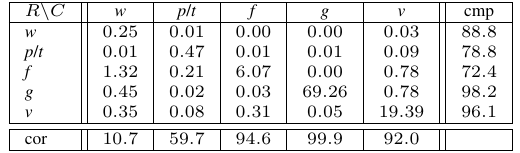
Table 7. Confusion matrix, completeness (cmp) and correctness (cor) for the variant CRF 5 200 using neighborhood N opt ,λ . The numbers in the confusion matrix are the respective percentage of the whole test set. R \ C : Reference (rows) vs. classification results (columns). neighborhood than for N 50 , in the order of 2 % for the first and of 1 % for the latter if 200 trees are used for the association potential. Consequently, the variant N opt ,λ performs better than N 50 in all cases, the margin being in the order of 1 %. If RF 100 is used for the association potential, this also holds for N opt,dim , whereas in case 200 trees are used N opt,dim performs similar to N 50 .